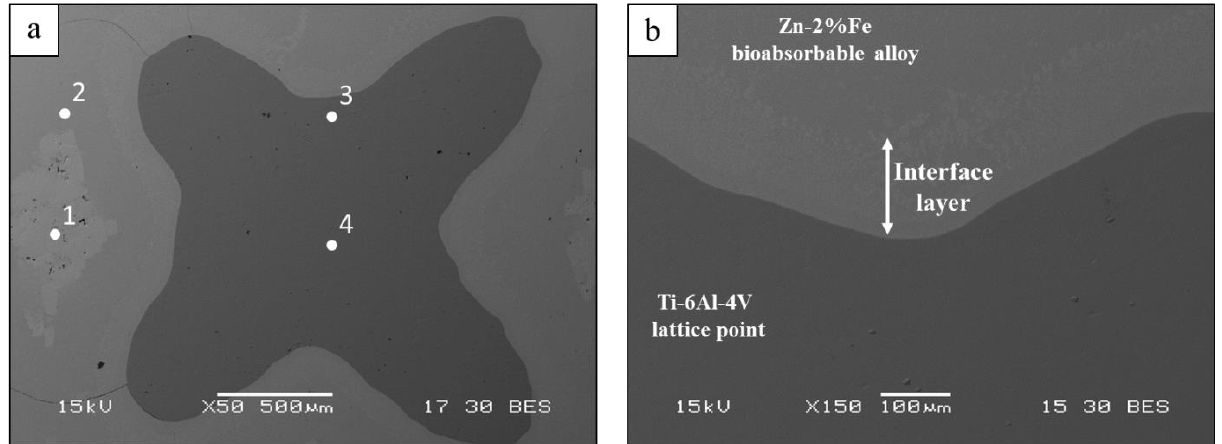
Figure 2. Microstructure of hybrid Ti-Zn system by SEM ( a ) points of EDS measurements ( b ) Close-up view at the interface between Ti-based lattice and Zn-based